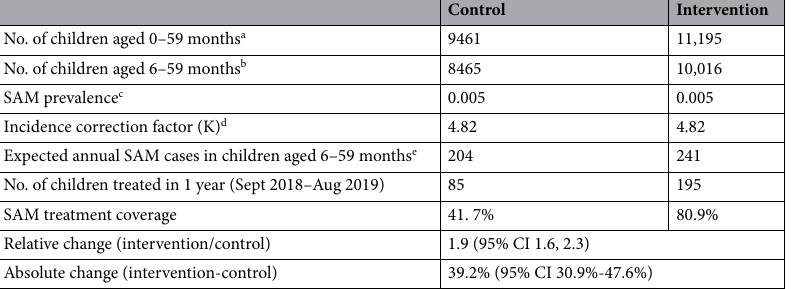
Table 4. Estimation of coverage of severe acute malnutrition treatment services. a Based of the 2015 projected census data for 2018/2019. b 89.47% of the < 5 population based on the 2015/16 DHS data. c National Nutrition survey 2018, Simiyu Region. d Based on meta-analysis of studies from West Africa 19 . e No. of children aged 6–59 months × SAM prevalence × (1 + K). The 95% CIs were calculated using a calculator based on published formulae.